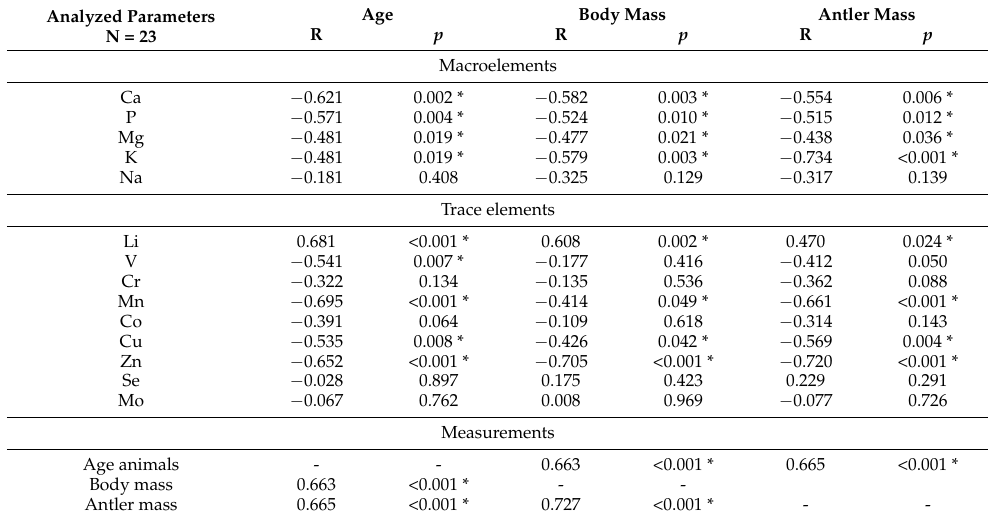
Table 5. Relationship between the concentration of macroelements and trace elements on age, body mass and antler mass of farmed fallow